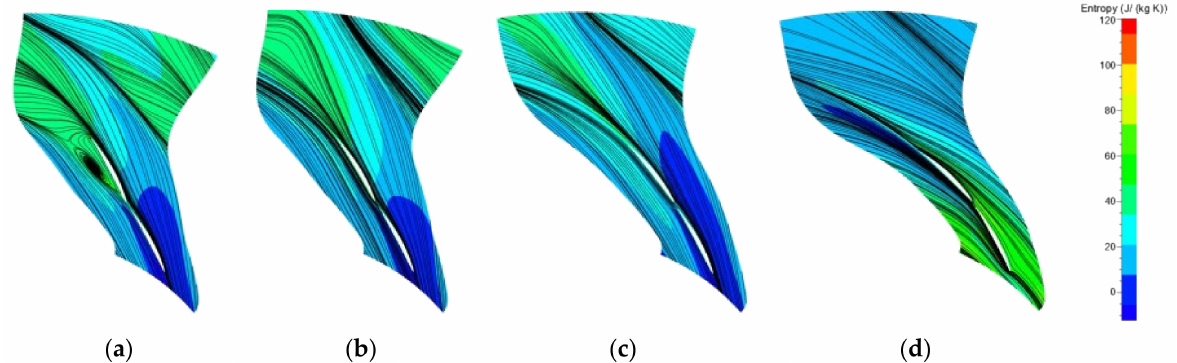
Figure 14. Entropy contour and streamline distribution at 10% span in different cases. ( a ) 0 ◦ model; ( b ) 3 ◦ model; ( c ) 10 ◦ model; and ( d ) 18 ◦ model.